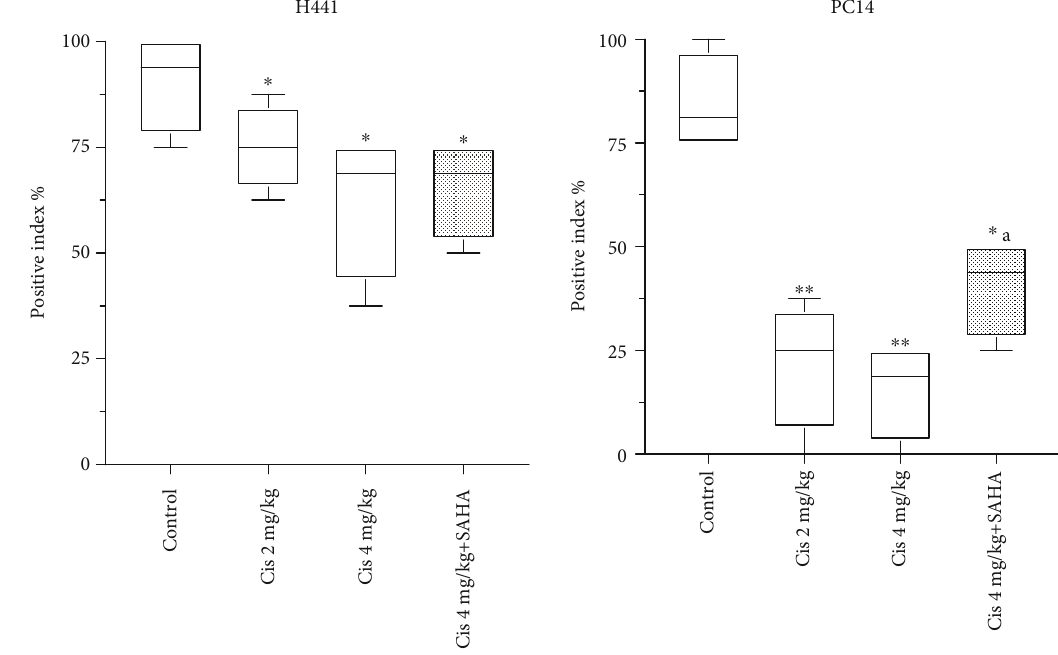
Figure 7: Quanti fi cation of AH3 immunoreactivity in the tumors (based on the data in Figure 5). Data are mean and mix/max. Values; di ff erent superscript letters indicate signi fi cant di ff erences ( ∗ p < 0 : 05 , ∗∗ p < 0 : 01 compared to controls; a p < 0 : 05 , Group C vs. Group